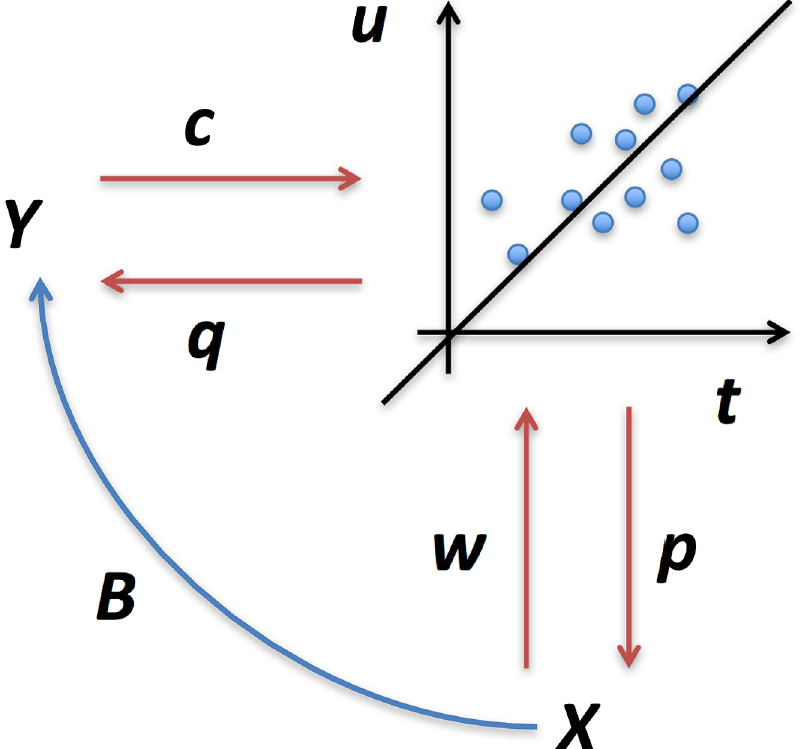
Fig 1. Schematic illustration of partial least squares regression. Two blocks of data, X and Y , are projected by w and c onto latent components, t and u , and least squaresregressionis performed. p and q